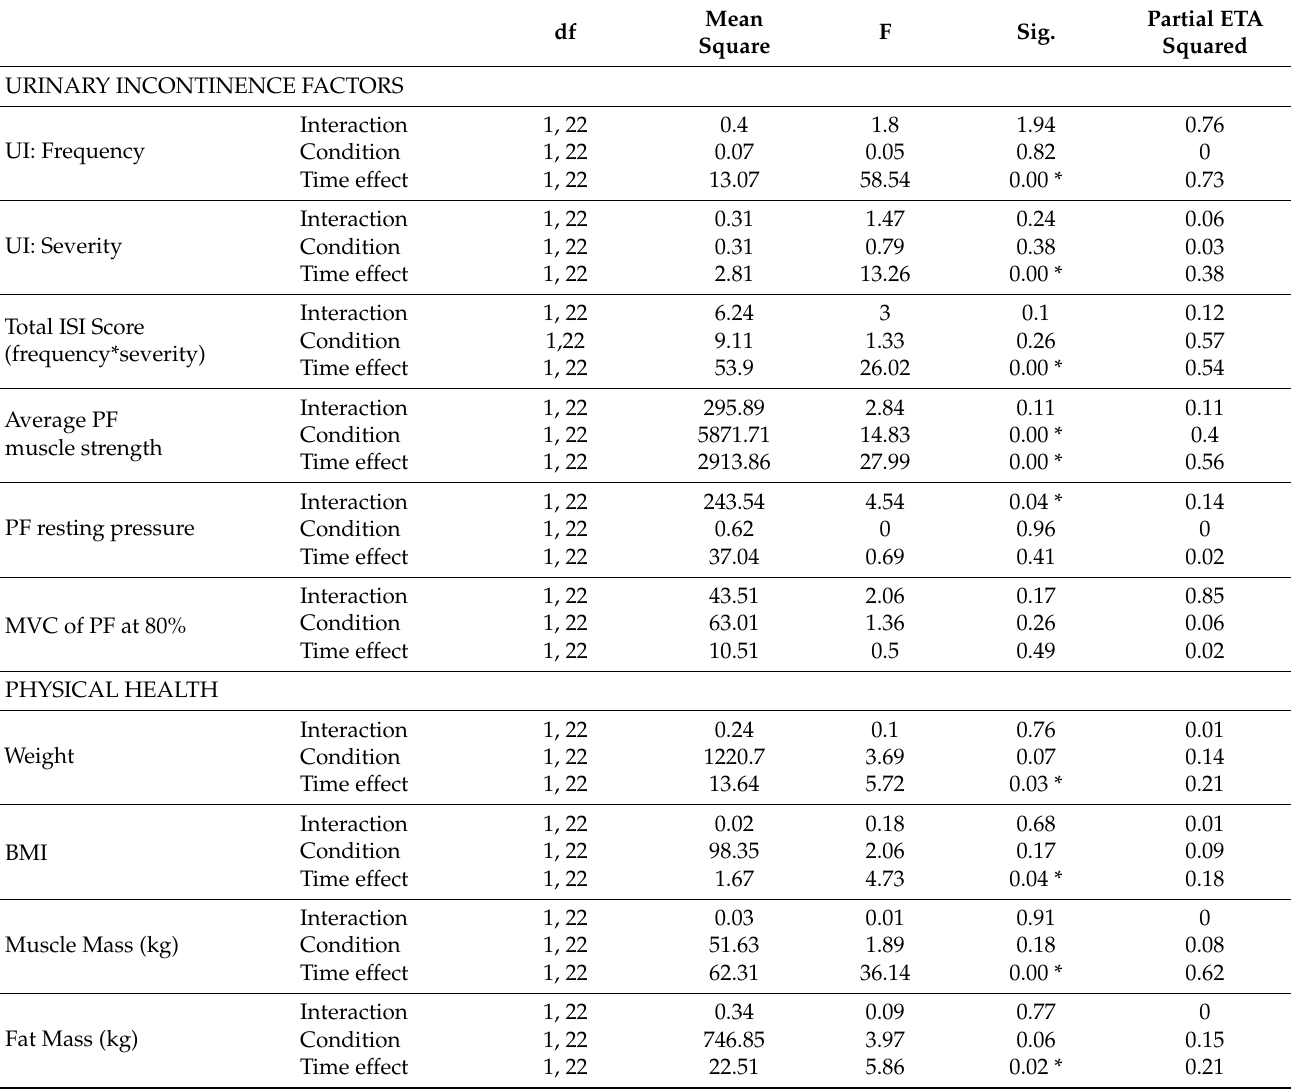
Table 3. Two-way ANOVA results of difference between the RT group and KE + RT group.